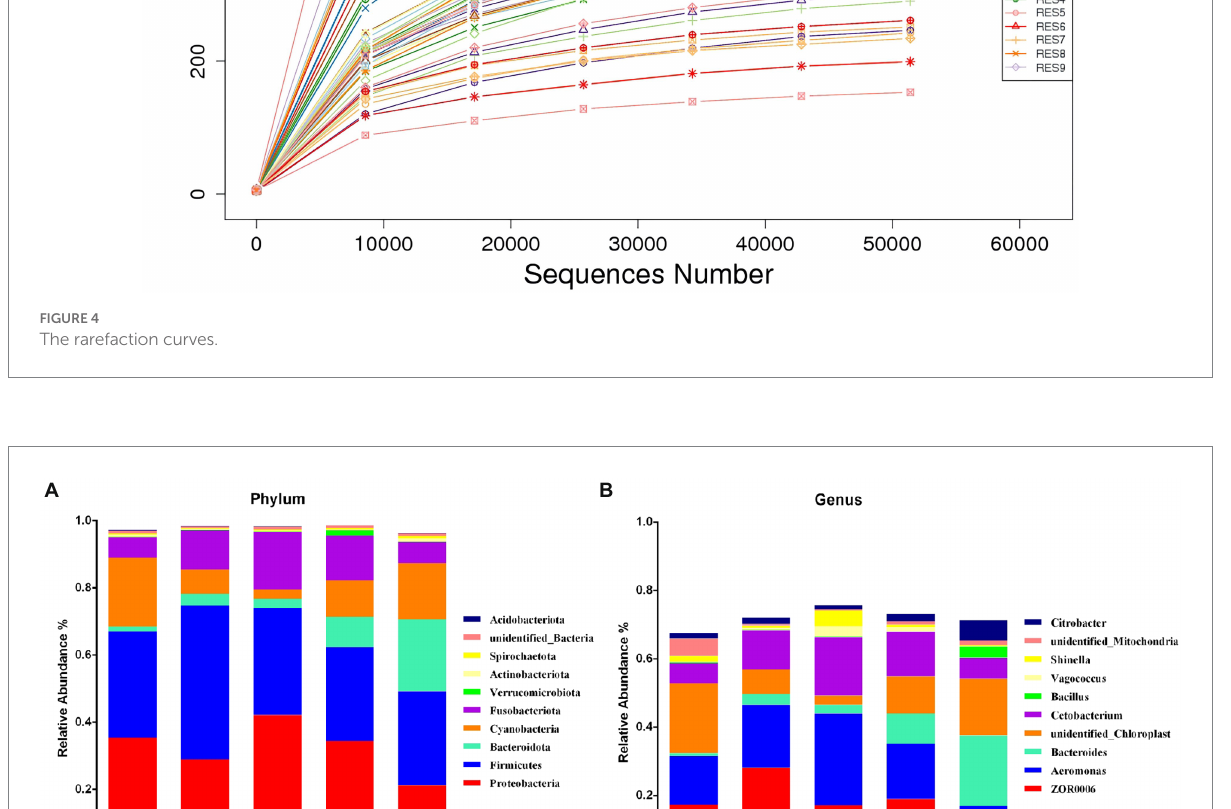
FIGURE 5 The relative abundance of gut bacteria at the level of (A) phylum and (B) genus ( n = 9 per treatment). Only the top 10 bacteria were presented. CON, control group; CUR, curcumin group; OPC, oligomeric proantho cyanidins group; CGA, chlorogenic acid group; RES, resveratrol group.